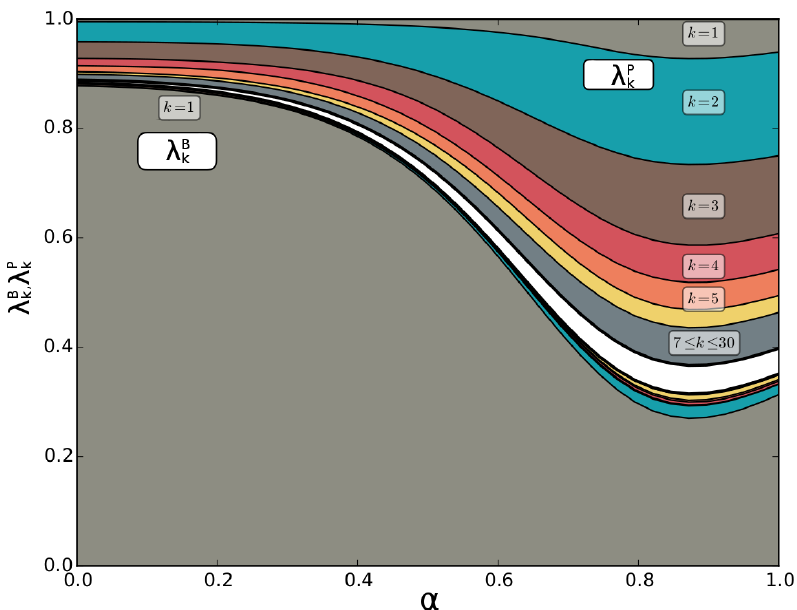
Figure 8. Decomposed eigenvalues λ B renewable mix α . The solar share increases towards α = 0, and the wind share increases towards α = 1. The white band in the middle represents ∑ N